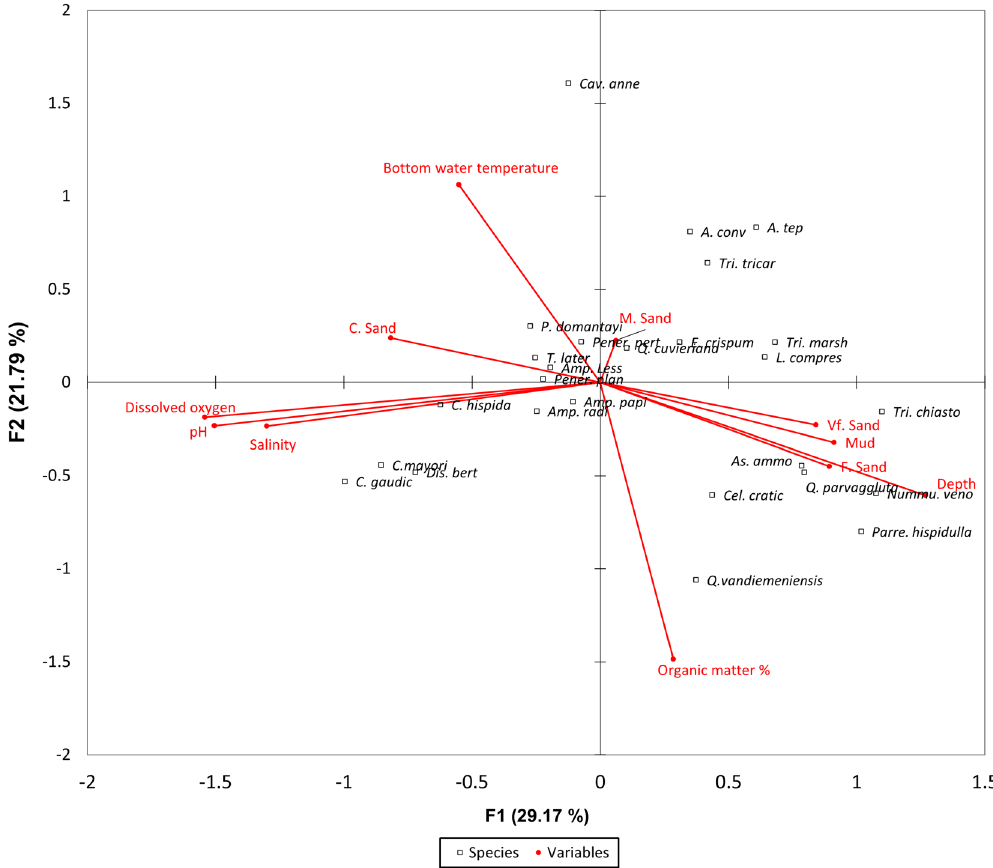
Figure 3. Species-environmental biplot based on Canonical Correspondence Analysis (CCA) of data collected from Pulau Tioman. The total variance of both axes 1 and 2 is (50.96%). (OM-organic matter; C. sand-coarse sand; DO- Dissolved oxygen; M. sand- Medium sand; F. sand- Fine sand; Vf, sand- Very fine sand) ( A. tep = Ammonia tepida ; Amp. less = Amphistegina lessoni ; Amp. papi = Amphistegina papillosa ; Amp. radi = Amphistegina radiata ; As. ammo = Assilina ammonoides ; C. gaudic = Calcarina gaudichaudii ; C. hispida = Calcarina hispida ; C. mayori = Calcarina mayori ; Cav. Anne = Cavarotalia annectens ; Cel. cratic = Cellanthus craticulatus ; Dis. bert = Discorbinella bertheloti ; E. crispum = Elphidium crispum ; L. compres = Lachlanella compressiostoma ; Nummu. veno = Nummulites venosus ; P. domantayi = Pararotalia domantayi ; Pener. hispidulla = Parrelina hispidulla ; Pener. pert = Peneroplis pertusus ; Pener. plan = Peneroplis planatus ; Q. vandiemeniensis = Quinqueloculina vandiemeniensis; Q. cuvieriana = Quinqueloculina cuvieriana ; Q. parvaggluta = Quinqueloculina parvaggluta ; T. later = Textularia lateralis ; Tri. marsh = Triloculina marshallana ; Tri. tricar = Triloculina tricarinata ; Tri. chiasto = Triloculinella chiastocytis